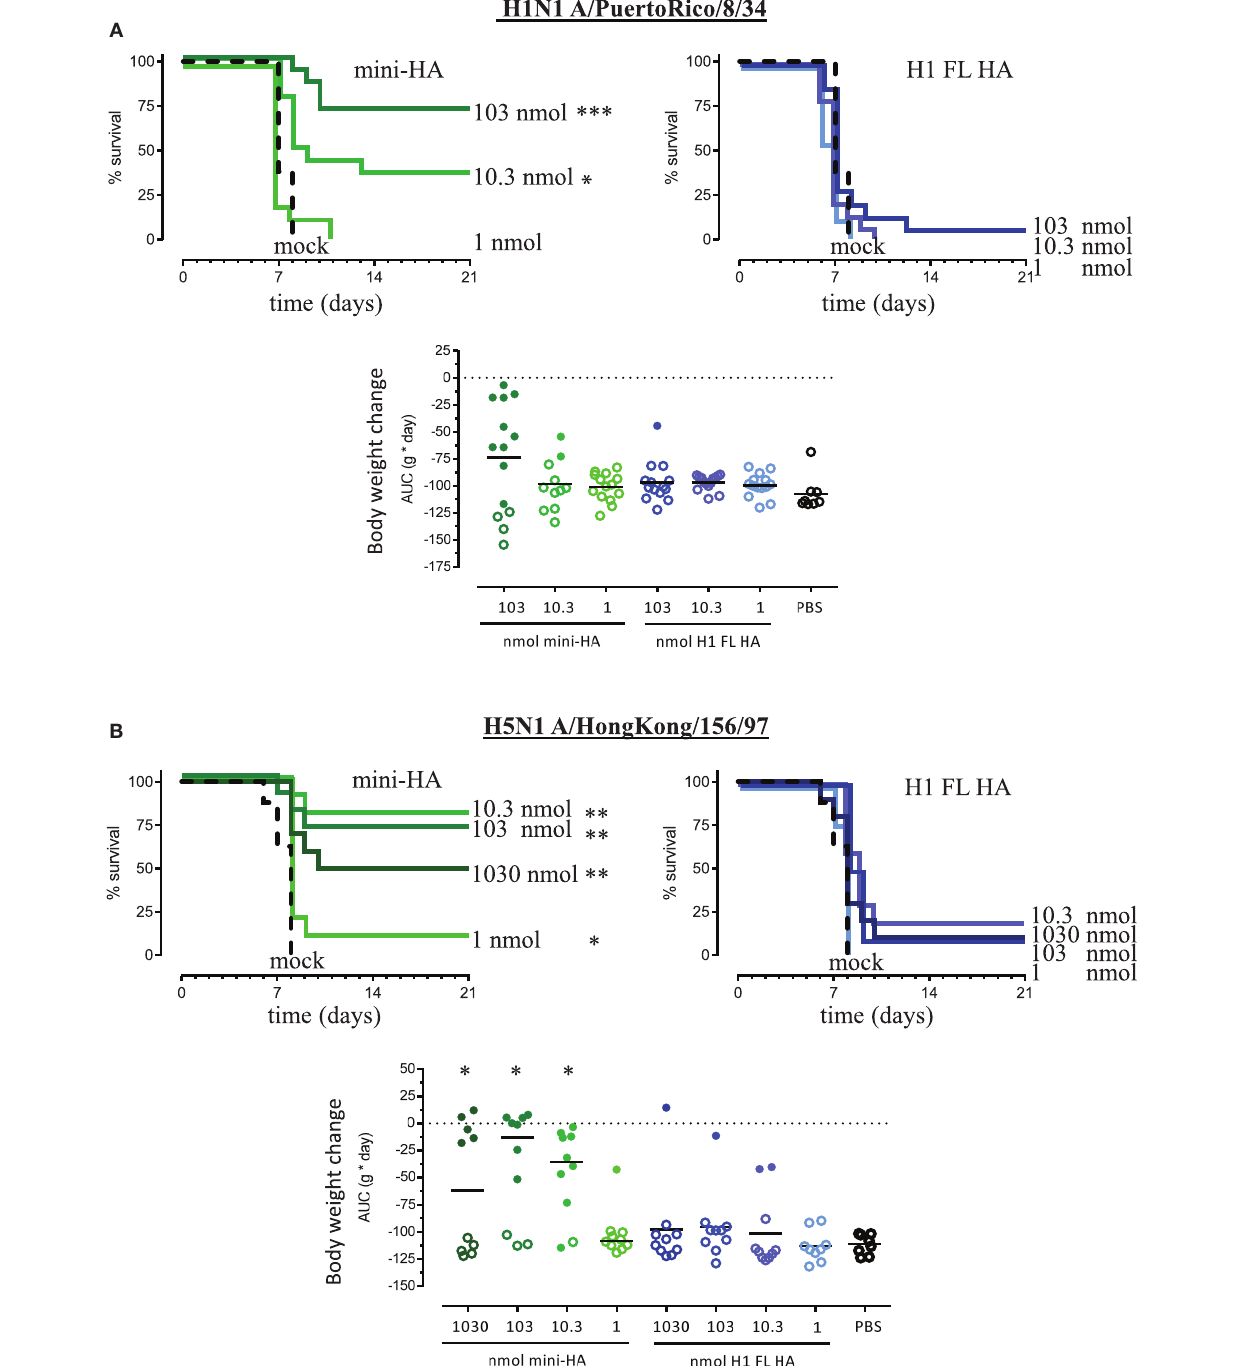
Frontiers in Immunology |